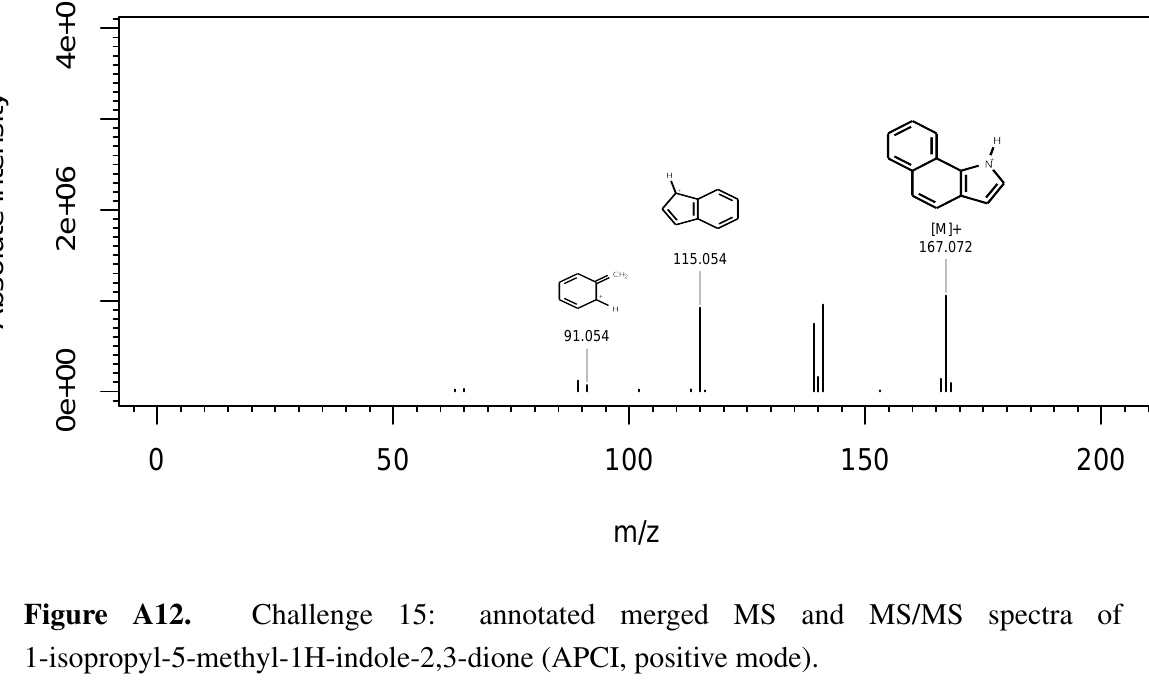
Figure A12. Challenge 15: annotated merged MS and MS/MS spectra